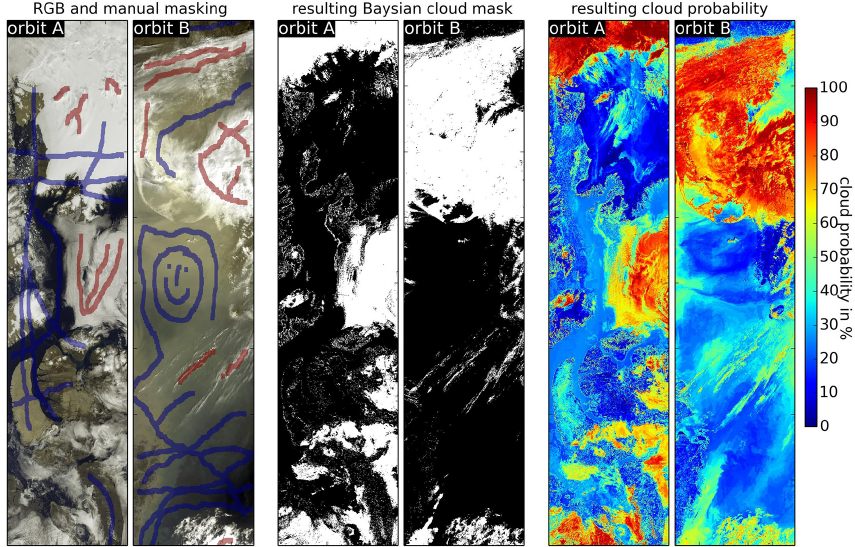
Figure 12. Manual classifications of the scenes shown in Figs. 1 and 2. Shown are the cloudy and non-cloudy classification together with an RGB view for two scenes (two leftmost panels, blue is non-cloudy, red is cloudy), the resulting cloud mask (two middle panels), and the cloud probability (rightmost two